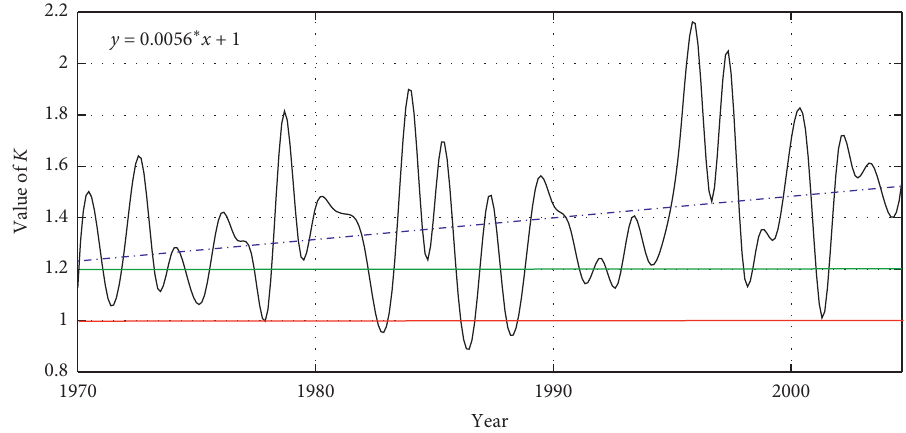
Figure 13: Long series k - t fitting